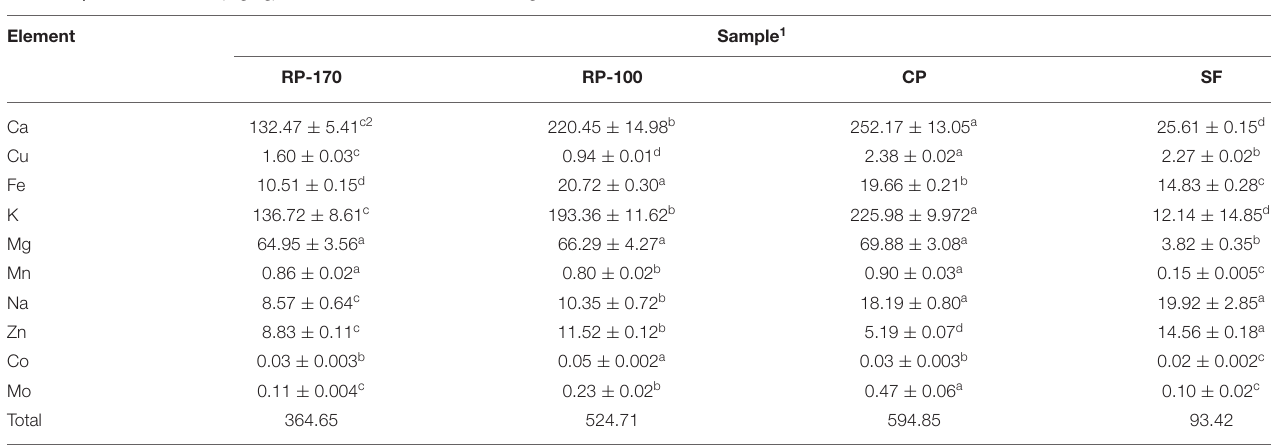
TABLE 4 | Mineral contents (mg/kg) of lemon seed oils extracted using different methods.